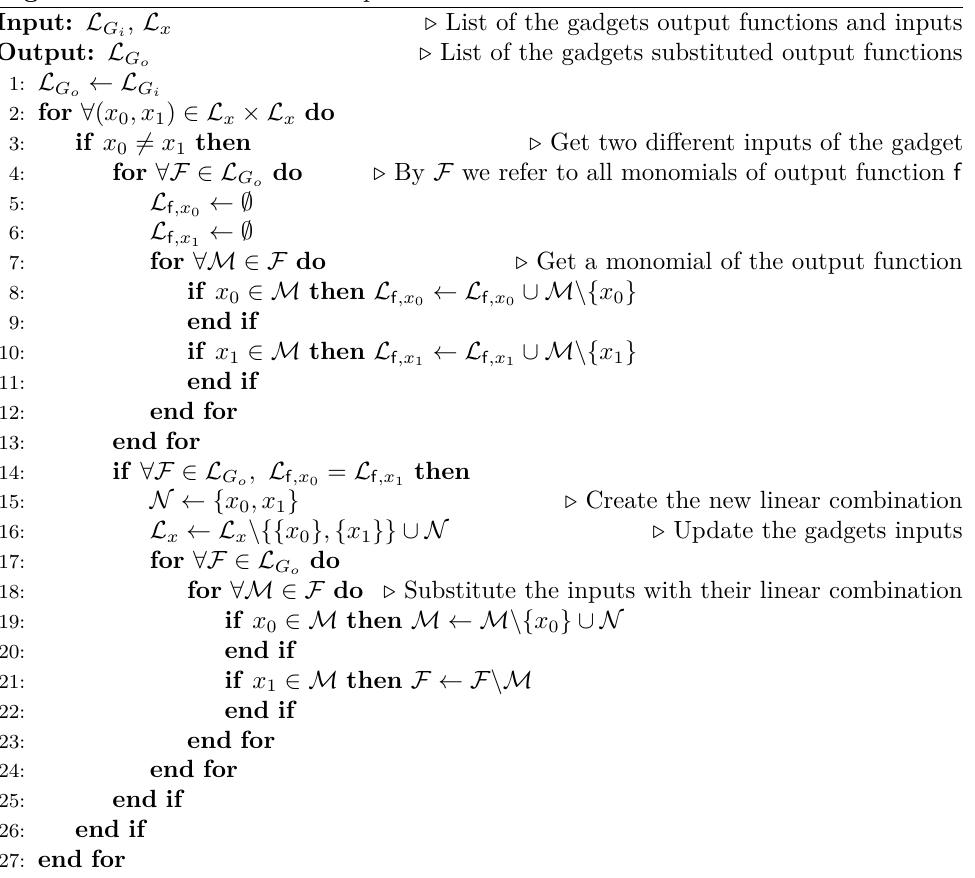
Algorithm 3 Search for linear input